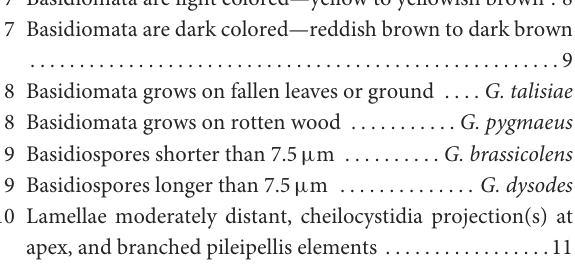
8 Basidiomata grows on fallen leaves or ground . . . . G.